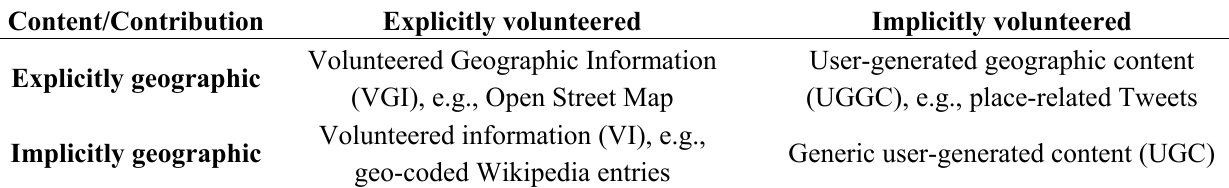
Table 1. Typology of user-generated